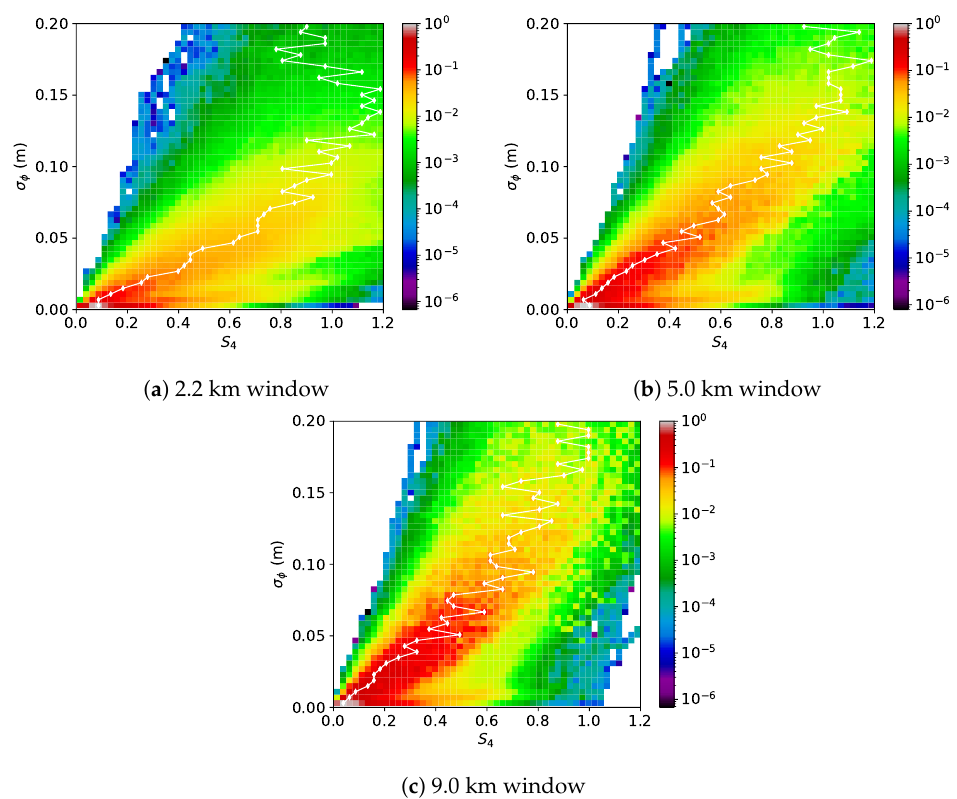
> 13.5 rad/km 2 . 0